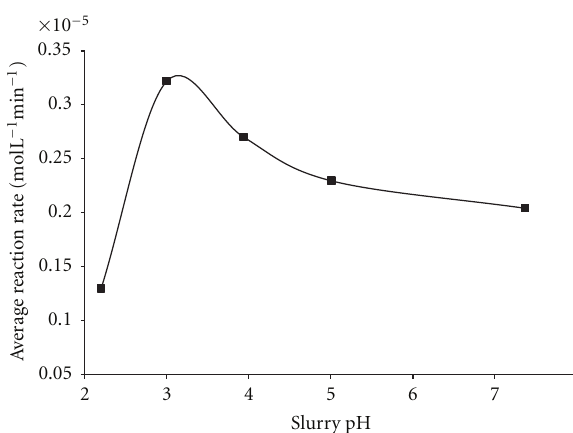
Figure 3: E ff ect of slurry initial pH on average reaction rate (TOC initial concentration = 24 . 62 ± 0 . 44mgL − 1 , average reaction temperature = 27 ◦ C, 0.07 gL − 1 catalyst loading, 1.8 Lmin − 1 air flow rate and 4.4Lmin − 1 slurry flow rate).